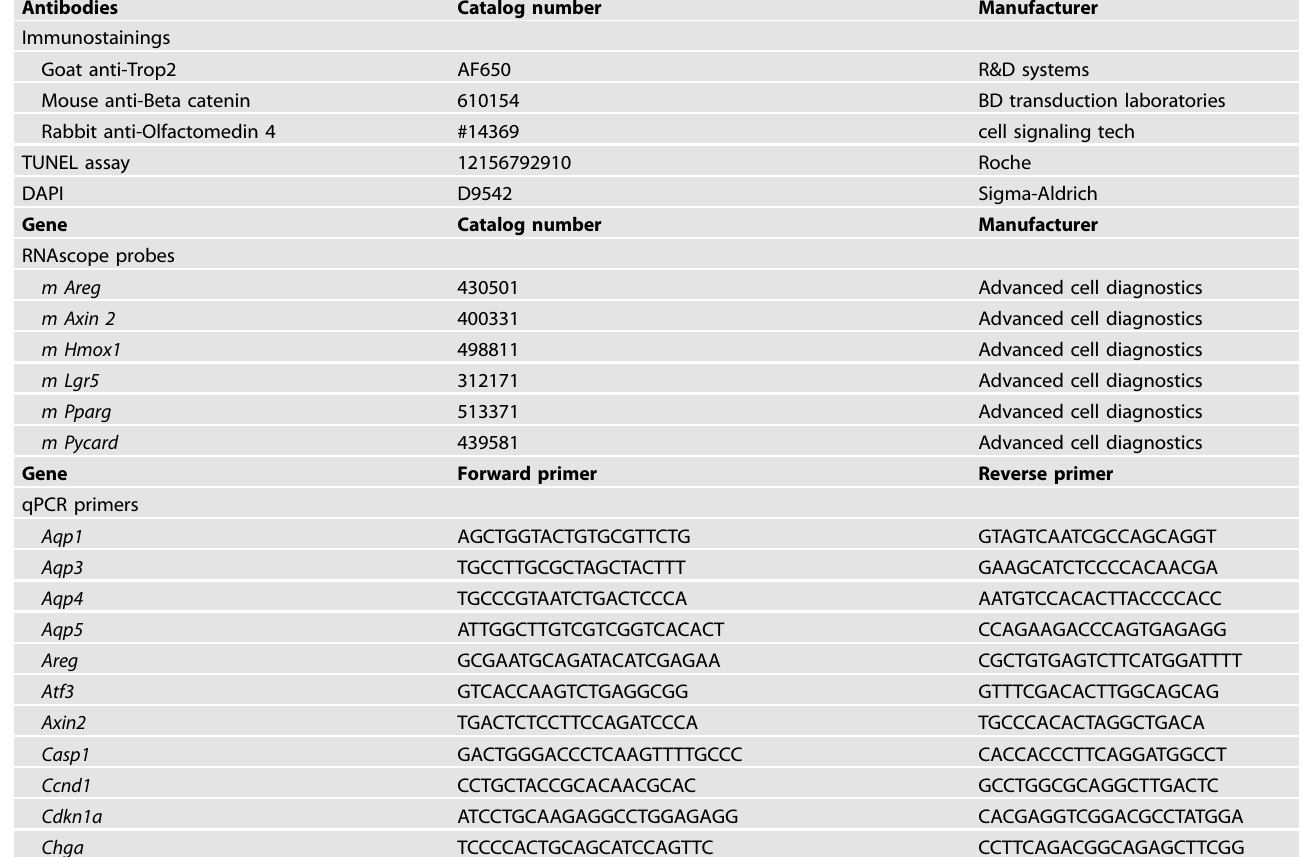
Table 2. List of material used for immunostainings, in situ hybridization, and qRT-PCR experiments.